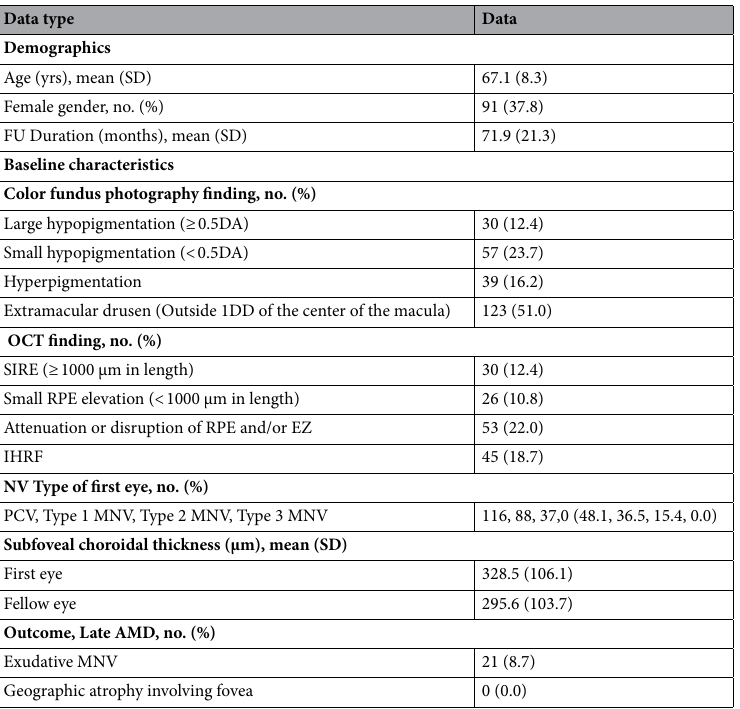
Table 1. Summary of data collected from the 241 enrolled patients. SD = Standard deviation; FU = Follow-up; NV = Neovascularization; PCV = Polypoidal choroidal vasculopathy; MNV = Macular neovascularization; DA = Disc area; DD = Disc diameter; SIRE = Shallow irregular RPE elevation; EZ = Ellipsoid zone; IHRF = Intraretinal hyperreflective foci; AMD = Age-related macular